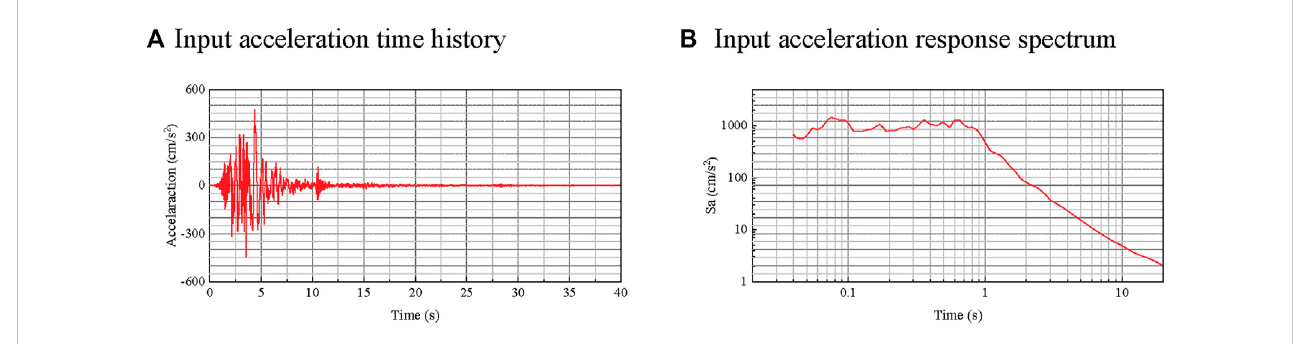
FIGURE 6 Input ground motion for site seismic response analysis and its response